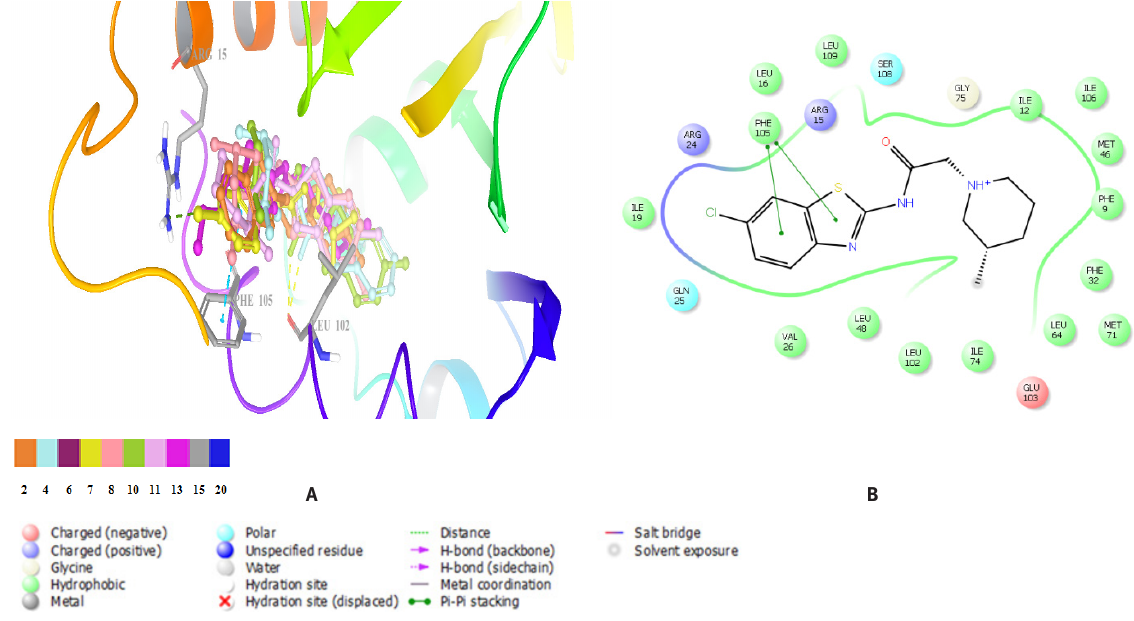
Figure: 1: Docked poses of compounds 2 , 4 , 6 , 7 , 8 , 10 , 11 and 13 (Yellow dashes: Hydrogen bonding; Blue and green dashes: π-π interactions) ( A ) and interactions of compound 6 in the active site of Ae SCP2 ( B